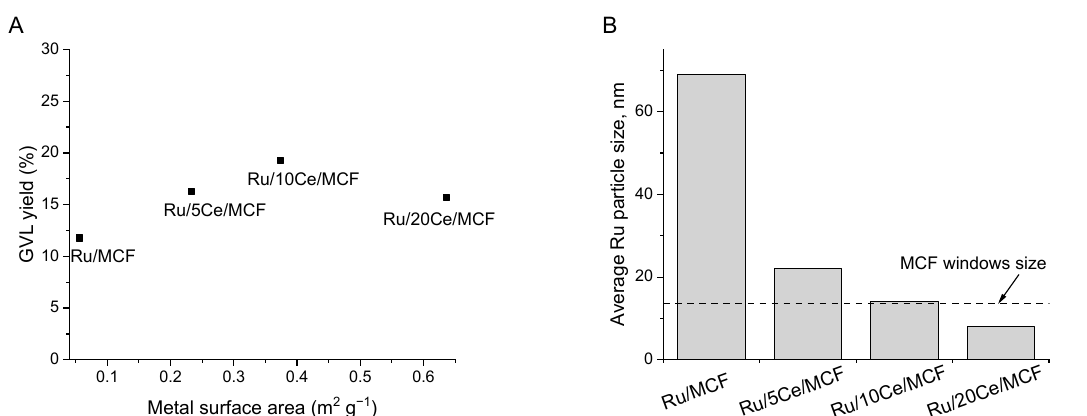
Figure 4. ( A ) The relation between GVL yield and metal surface area of Ru in the catalysts. ( B ) Average Ru particle size vs. MCF windows size.